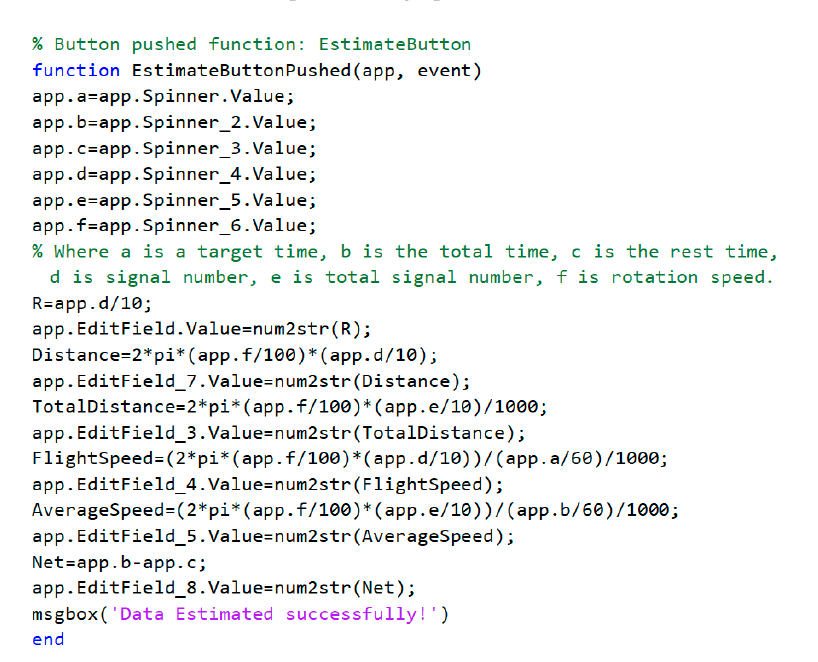
Figure 10. The main code of functions used for flight parameters to estimate rotation speed, flight speed, flight distance, average flight speed, total distance, and actual flight time.